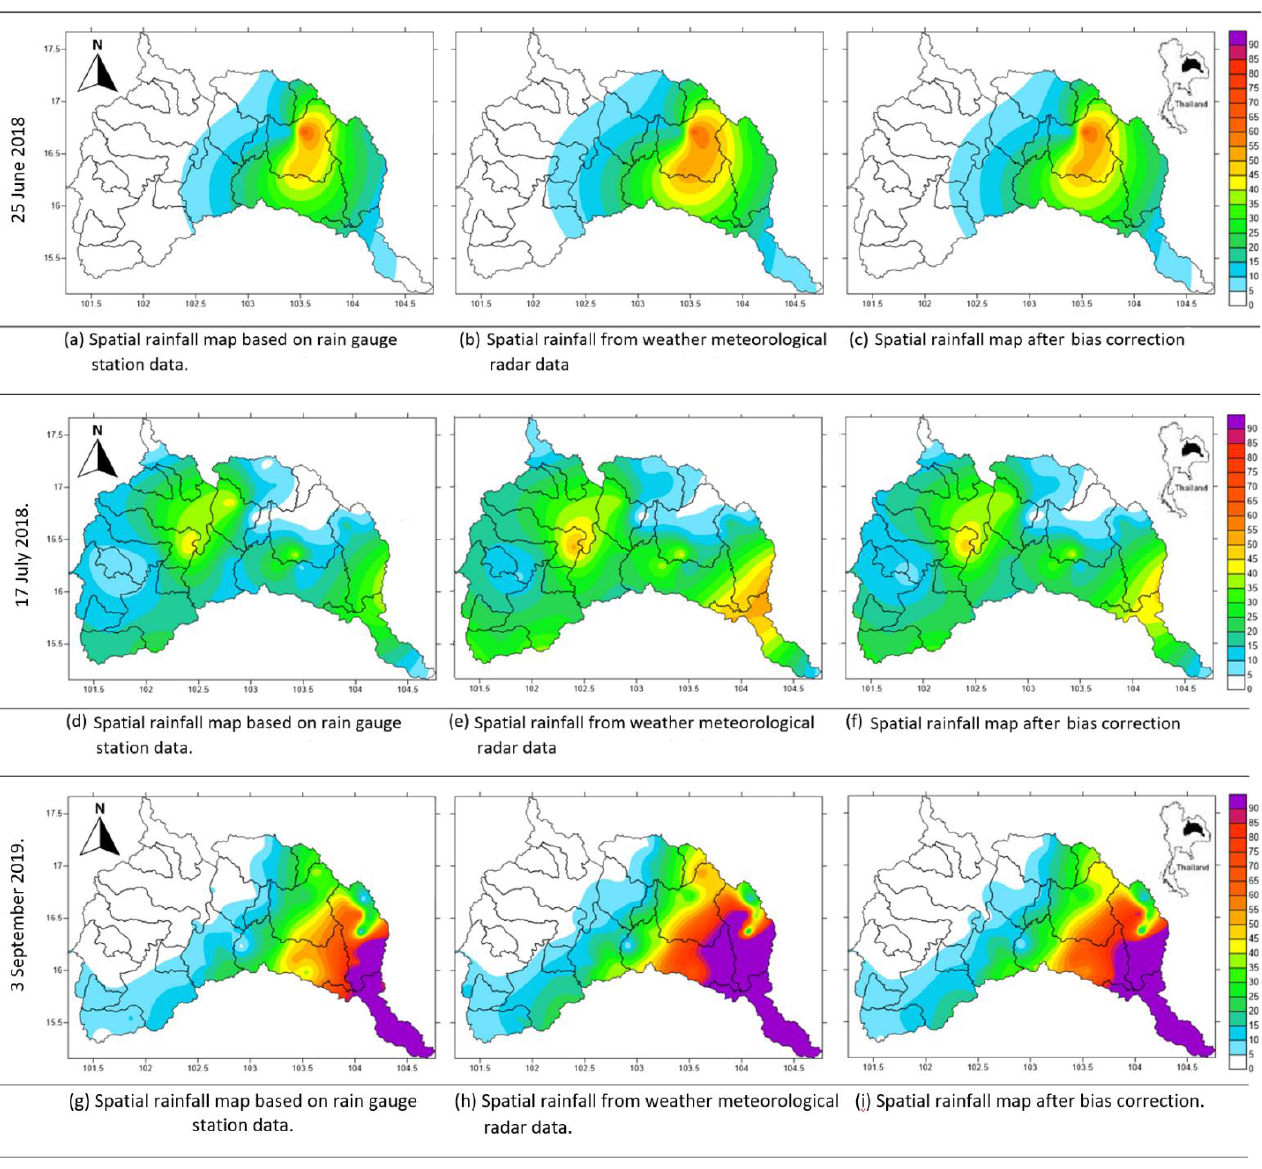
Figure 8. ( a – i ) 24 h spatial rain maps based on rain gauge after Kriging, based on radar, and after bias correction for the Chi Basin for 25 June 2018, 17 July 2018, and 3 September 2019.